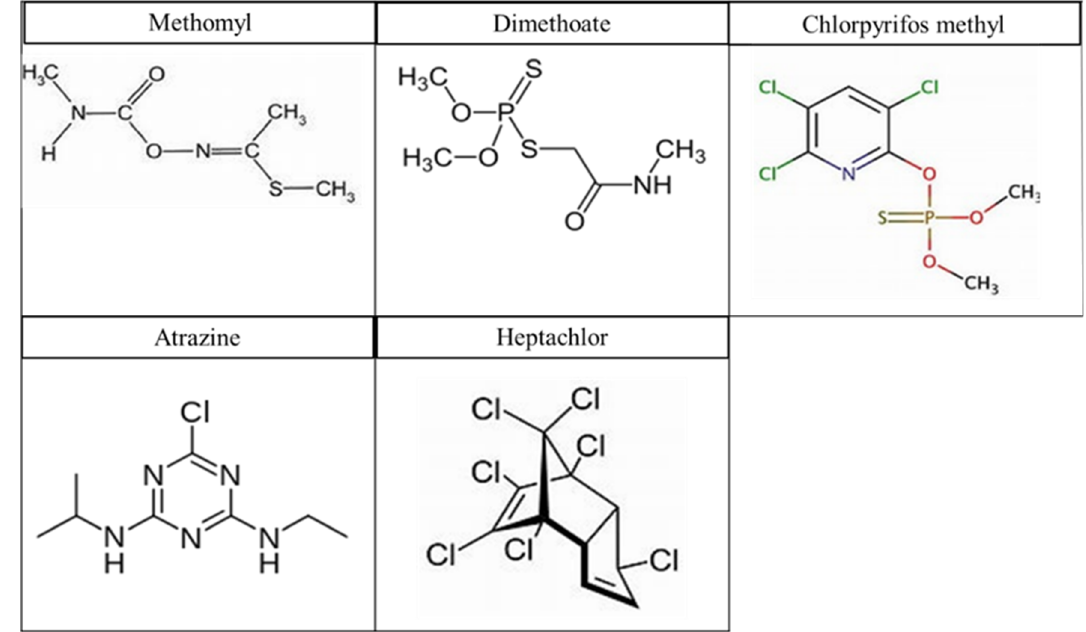
Figure 1. The chemical structures of the five pesticides.